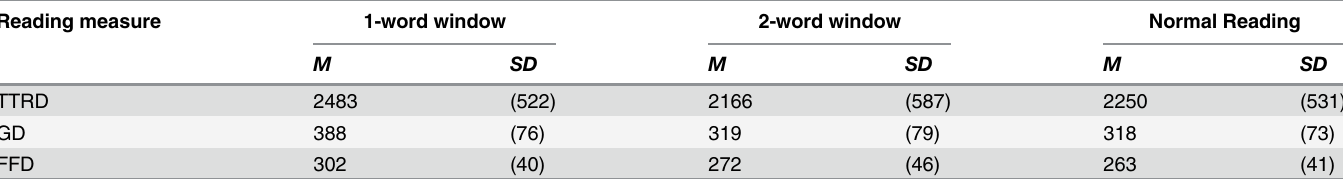
Table 2. Mean reading time measures [in ms] for the three preview conditions. Reading measure